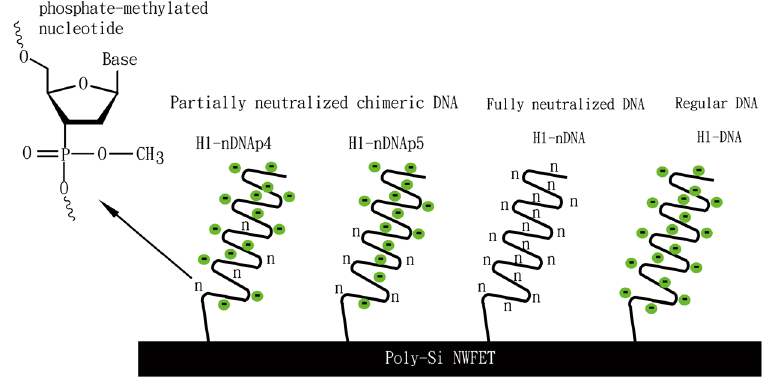
Figure 1. Schematic illustration of four DNA probes used in FET measurements. Phosphate-methylated nucleotides are denoted by “n”.